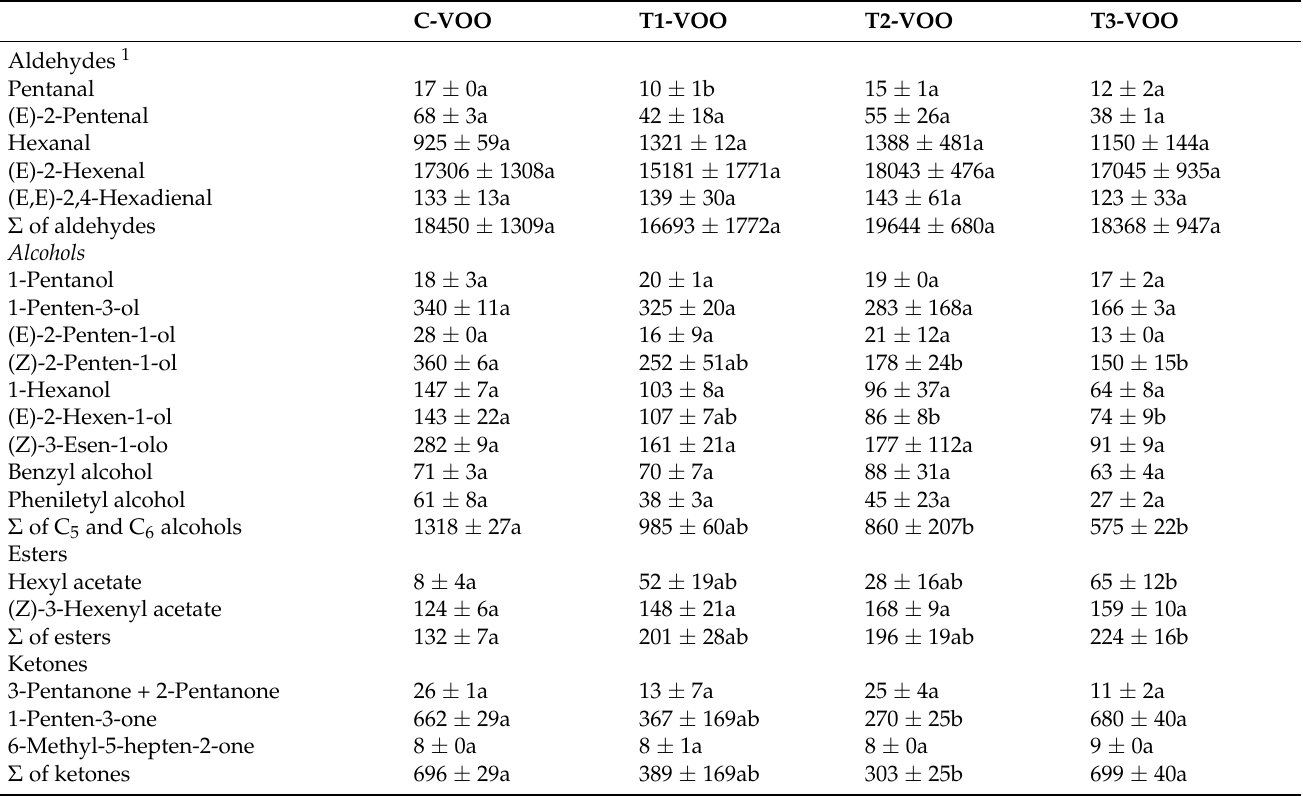
Table 5. Volatile composition ( µ g/kg) of Peranzana VOOs extracted at different